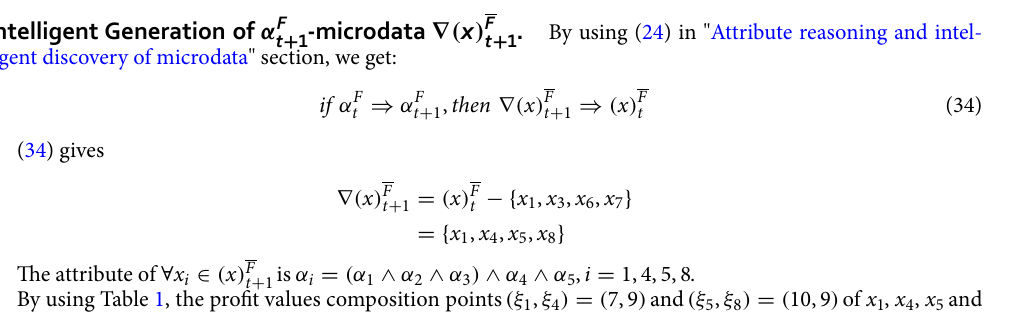
Ellipse curve model and its encryption